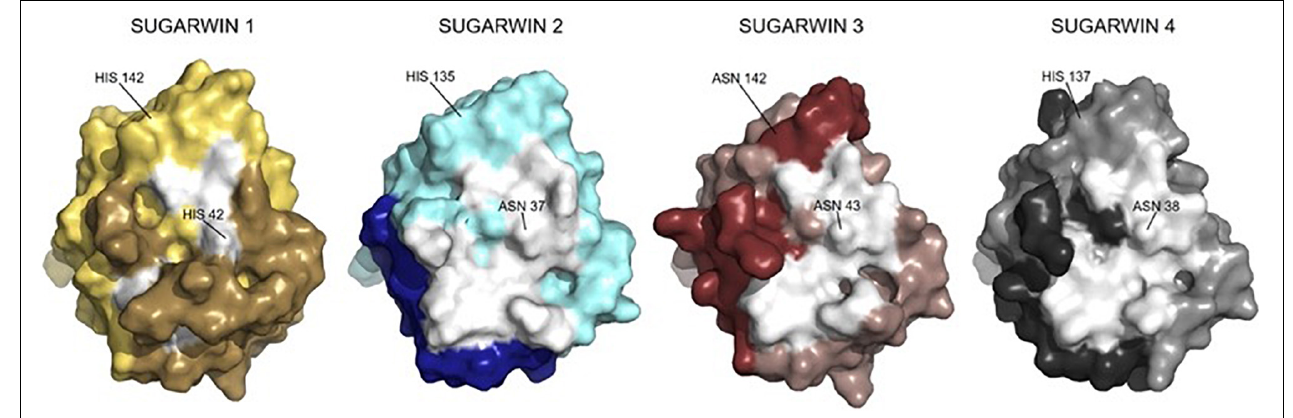
FIGURE 8 | Structures of SUGARWINs with emphasis on the chitosan binding site. Structures of SUGARWINs 1, 2, 3 and 4 in surface representation showing, in white, the regions previously identified as the binding site for chitosanase activity in SUGARWIN2. Darker colors indicate regions of major flexibility according to the RMSF analysis. These superpose with the binding site regions in a few cases. Residues in equivalent positions to the RNase active site histidines are